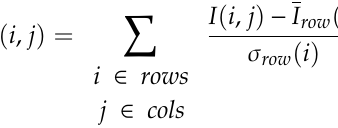
Figure 3. Example images from a nickel-base superalloy (Ren é 80) specimen: reference image ( a ) with template subsets T k , measurement image ( b ) with search subsets S k , zero-normalized cross-correlation results C k ( c ), and enlarged 3D graph of the right correlation peak ( d ). The images on the left (full size 2040 × 256 pixel) are split at the broken